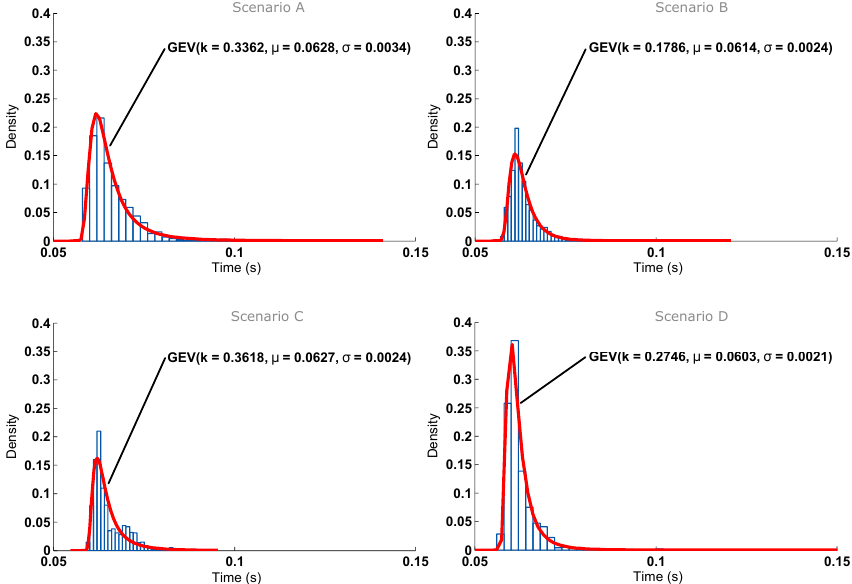
Figure 14. Response time for the scenarios considered in the test. ( A ) Short distance, line-of-sight; ( B ) Medium distance, line-of-sight; ( C ) Medium distance, non-line-of-sight; ( D ) Medium distance, non-line-of-sight,